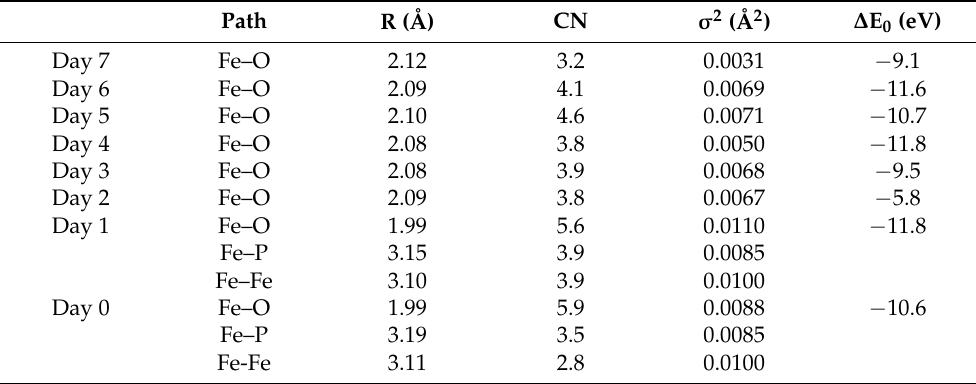
Table 1. Shell-by-shell extended X-ray absorption fine structure (EXAFS) fit results. Samples were collected daily (from day 0 to day 7) from culture filtrates of P. involutus growing on BSA-containing media 1